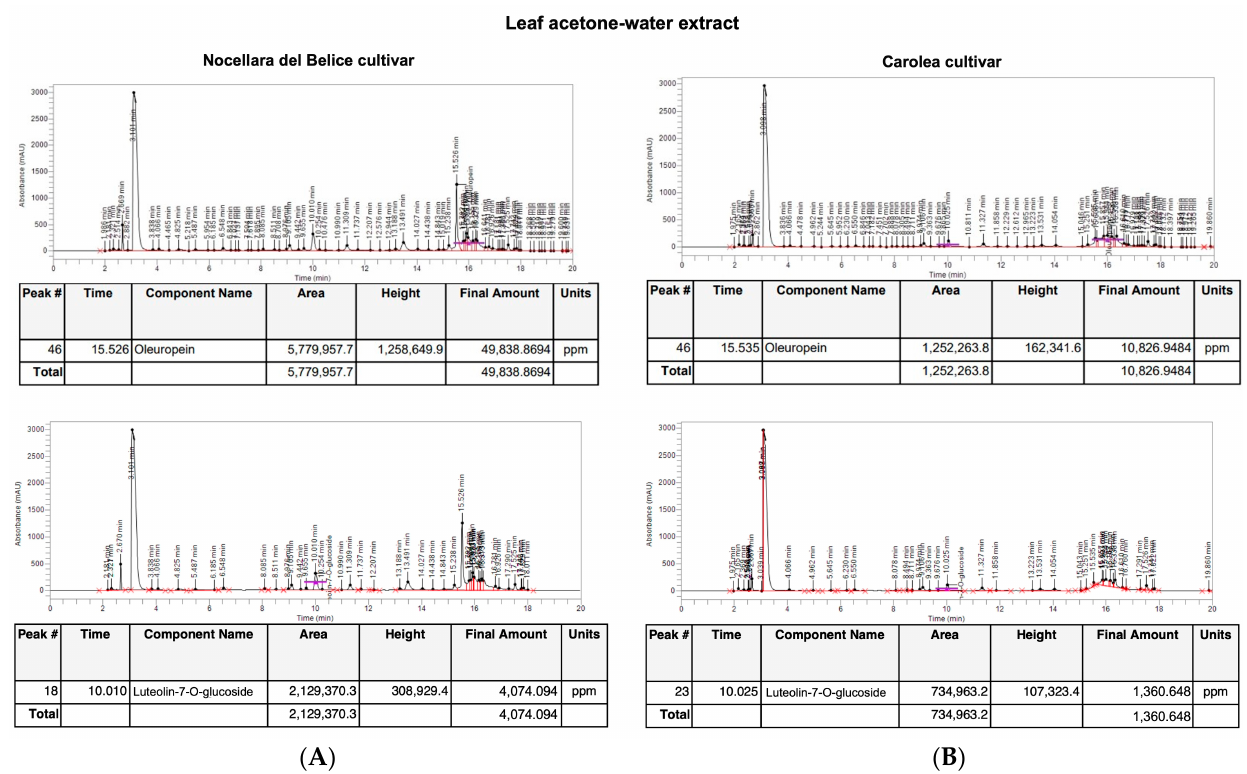
Figure 2. lHPLC analysis of O. europaea L. leaf acetone-water extract. Chromatogram of HPLC analysis of O. europaea L. leaf extract for ( A ) Nocellara del Belice cultivar and ( B ) Carolea